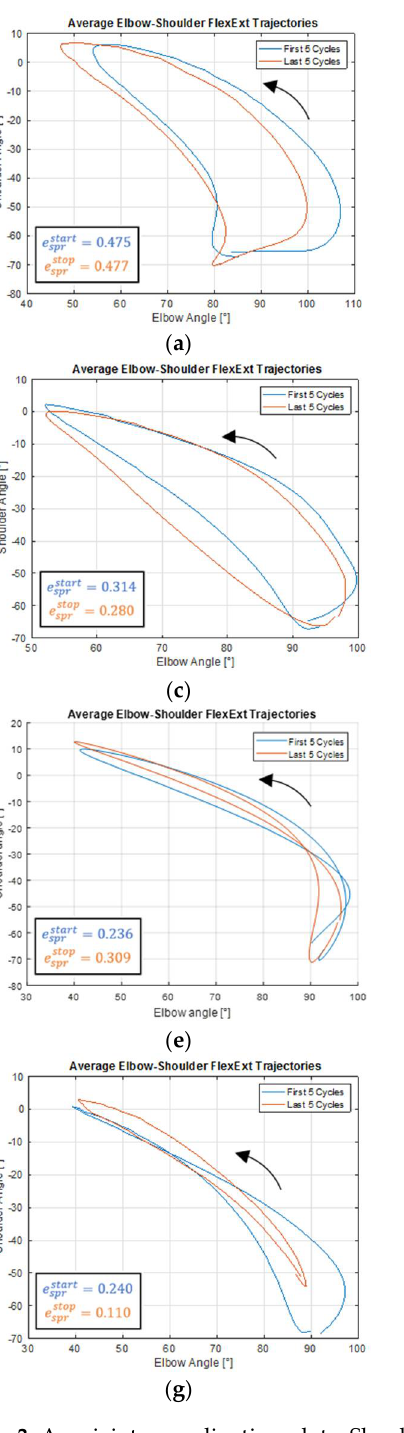
Figure 3. Arm joints coordination plots. Shoulder Flexion/Extension angle vs. Elbow Flexion Angle. On the Left side the Sprint tests, on the Right side the Wingate tests. For each plot, the early cycles (blue) and the last cycles (orange) are reported, as well as the aspect ratio e values and an arrow indicating the direction of the stroke cycle. From ( a ) to ( h ) the four subjects with increasing IWRF classification points are reported. ( a ) SJ1 (0.5): Sprint; ( b ) SJ1 (0.5): Wingate; ( c ) SJ2 (1.5): Sprint; ( d ) SJ2 (1.5): Wingate; ( e ) SJ3 (2.5): Sprint; ( f ) SJ3 (2.5): Wingate; ( g ) SJ4 (3.5): Sprint; ( h ) SJ4 (3.5):